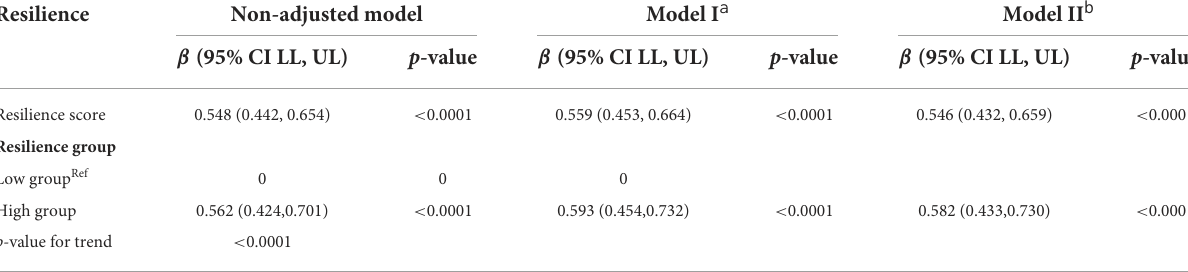
TABLE 2 Association between resilience score and calling score in the ICU nurses.